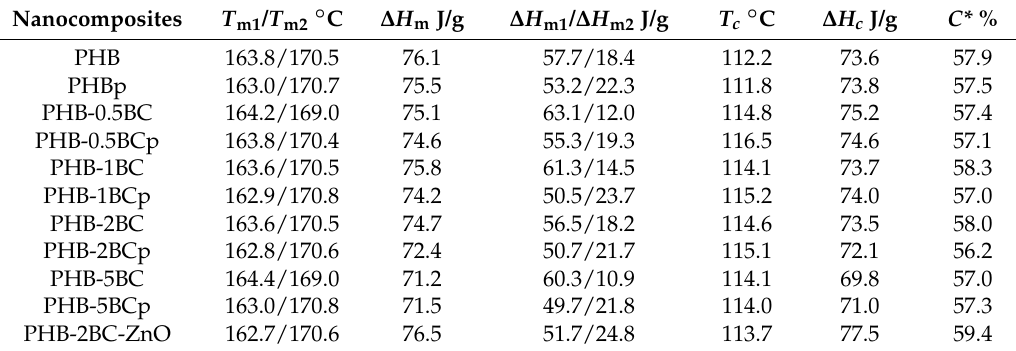
Figure 6. DSC melting ( a ) and cooling ( b ) scans of PHB nanocomposites; DSC melting ( c ) and cooling ( d ) scans of PHB nanocomposites after the plasma treatment. Table 2. Data obtained from the analysis of DSC melting and cooling thermograms.